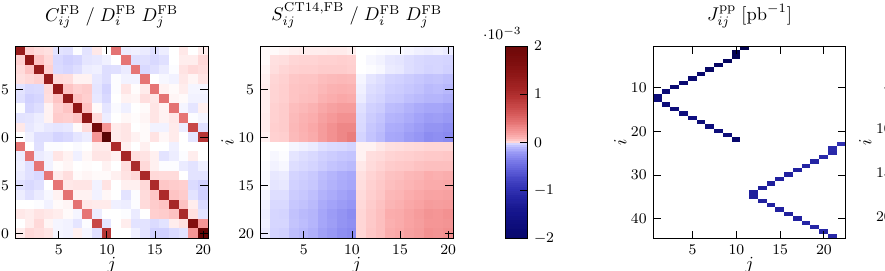
Fig. 6 As Fig. 2, but now for the forward-to-backward ratio. Indices i , j followthesameorderingasthedatapointsinFig.5,withtheindices 1 through 10 corresponding to the W − production and 11 through 20 to W +